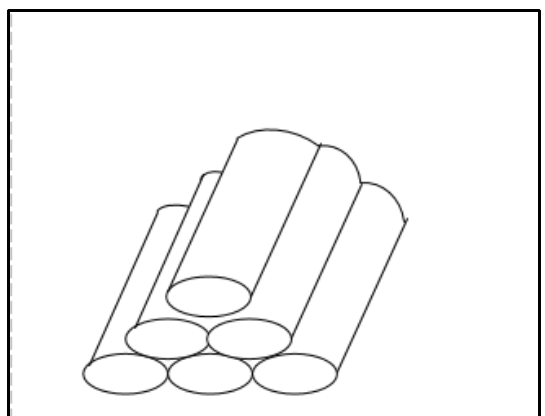
Figure 5. Tent stacking model.